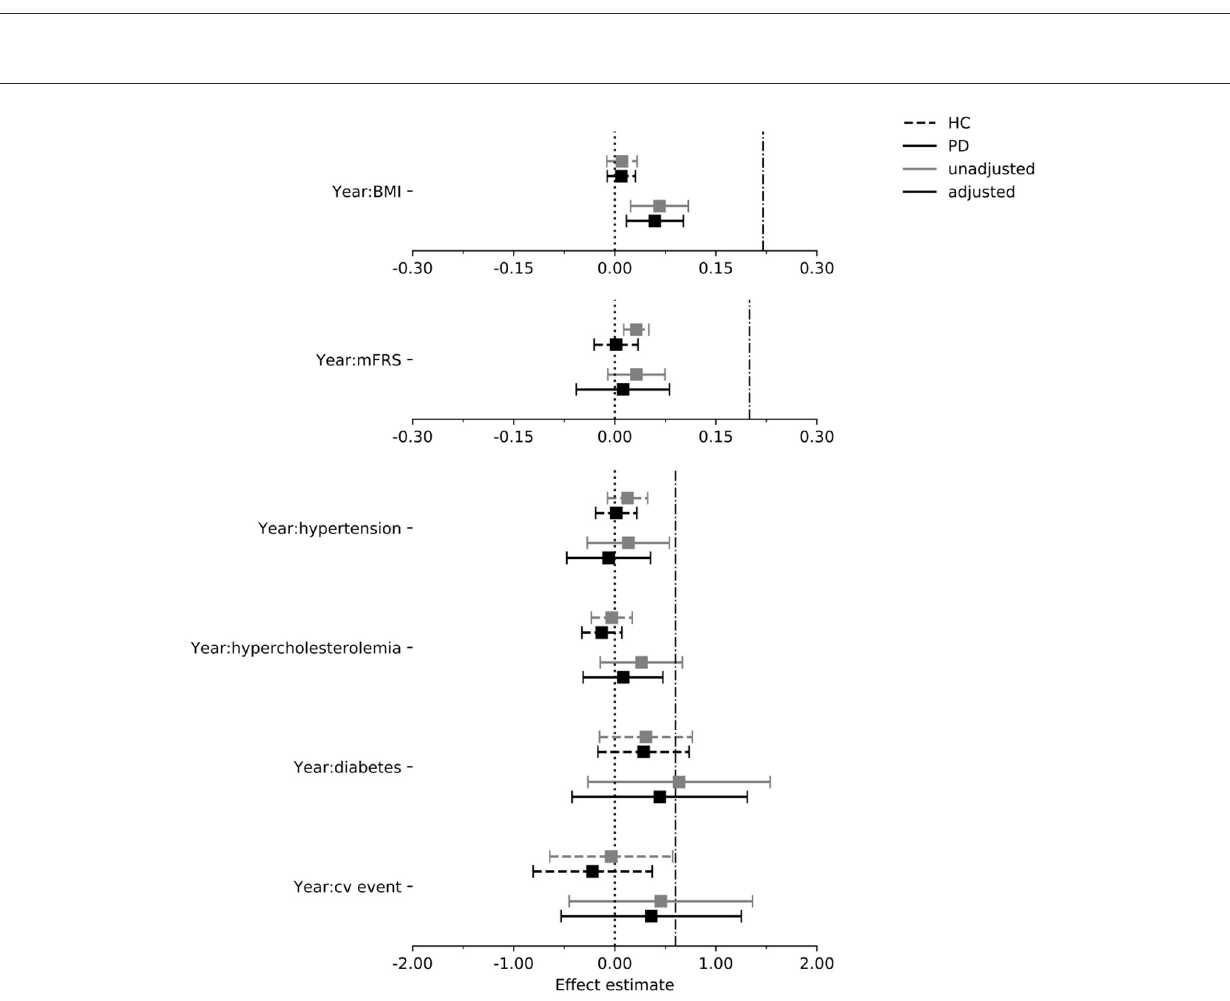
FIGURE3 Estimated effect of each exposure on the rate of change in the MDS-UPDRS part III score per year in the PPMI cohort. Dash dot line indicates threshold for assumed clinically relevant effect (see “Methods”). Intervals are 95% confidence intervals. mFrs, modified Framingham risk score; BMI, body mass index; cv, cardiovascular; HC, healthy control; PD, Parkinson’s disease.